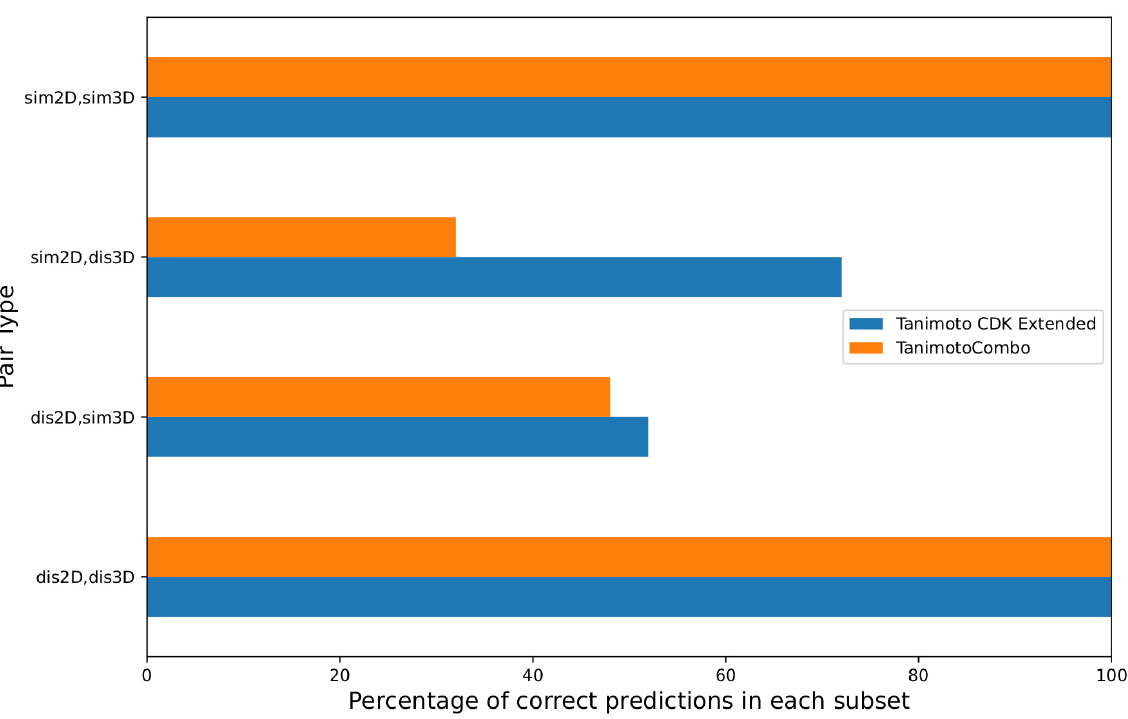
Figure 3. Percentage of predictions by the Tanimoto CDK Extended (t XT ) and TanimotoCombo (t CS ) models in the four calculated similarity subsets of the collected set. Both models correctly predicted 100% of the molecular pairs in the sim2D,sim3D and dis2D,dis3D subsets. All prediction errors occurred in the sim2D,dis3D and dis2D,sim3D subsets.